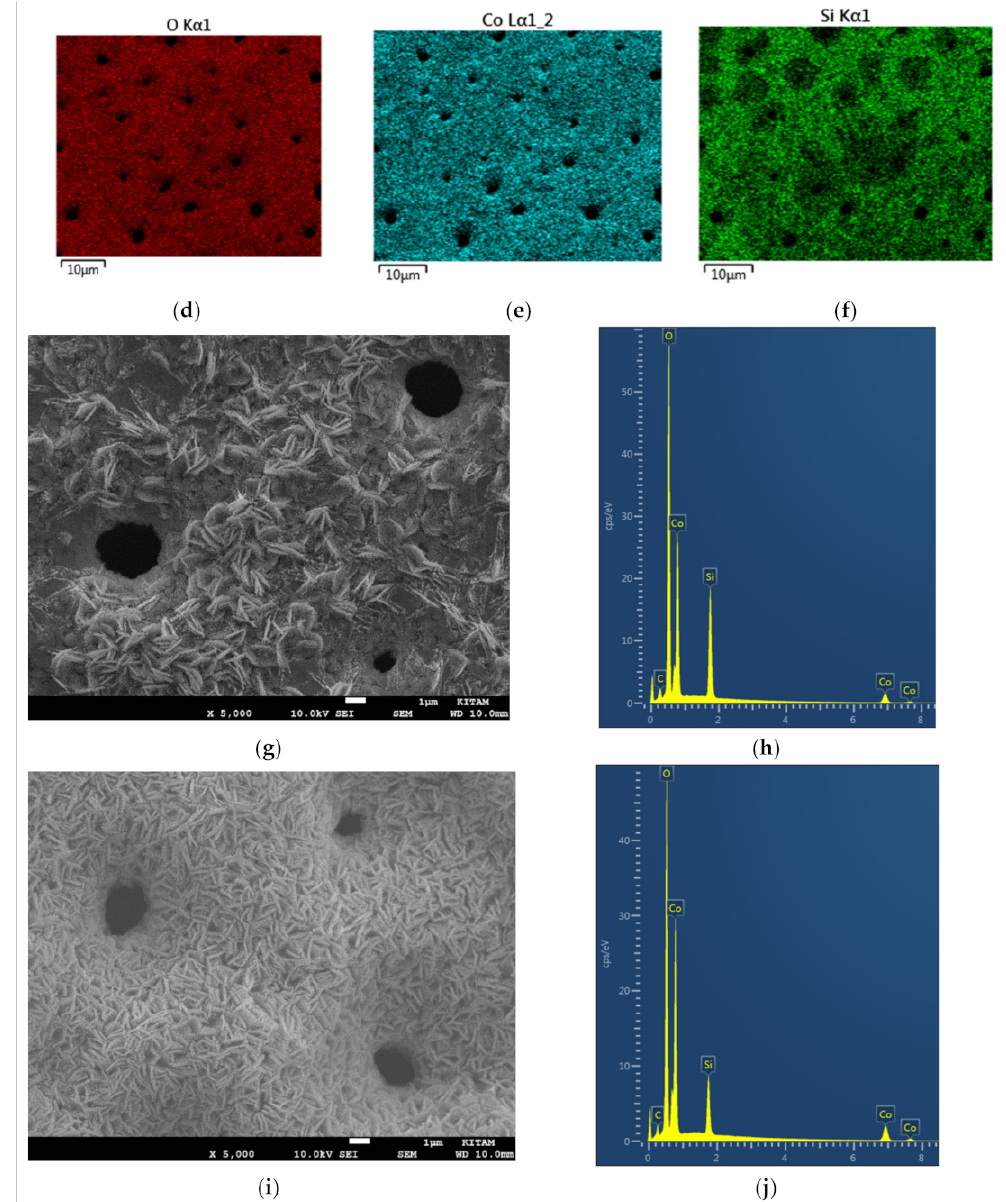
Figure 19. Analysis of the Co / Si = 1 catalyst region where the cobalt concentration is below that of the catalyst particle illustrated in Figure 18. EDS and SEM images of the Co / Si = 1 catalyst surface with lower-than-average cobalt concentration is present. ( a ) SEM image of the catalyst surface structure, Scale bar = 10 µ m; ( b ) EDX-image of the site where XRD-spot analyses are performed, Scale bar = 10 µ m; ( c ) Spectrum of the total area with composition [Co] = 0.329; [Si] = 0.109; [O] = 0.562; ( d ) Co-mapping; ( e ) Si-mapping; ( f ) O-mapping; ( g ) SEM of the area where cobalt concentration is the lowest as determined by the XRD-spot analysis, scale bar = 1 µ m; ( h ) Spectrum at location 12 where [Co] = 0.271; [Si] = 0.144; [O] = 0.585; ( i ) SEM of the area with maximum cobalt concentration (scale bar = 1 µ m); ( j )Spectrum at location 19 with [Co] = 0.381; [Si] = 0.068; [O] =